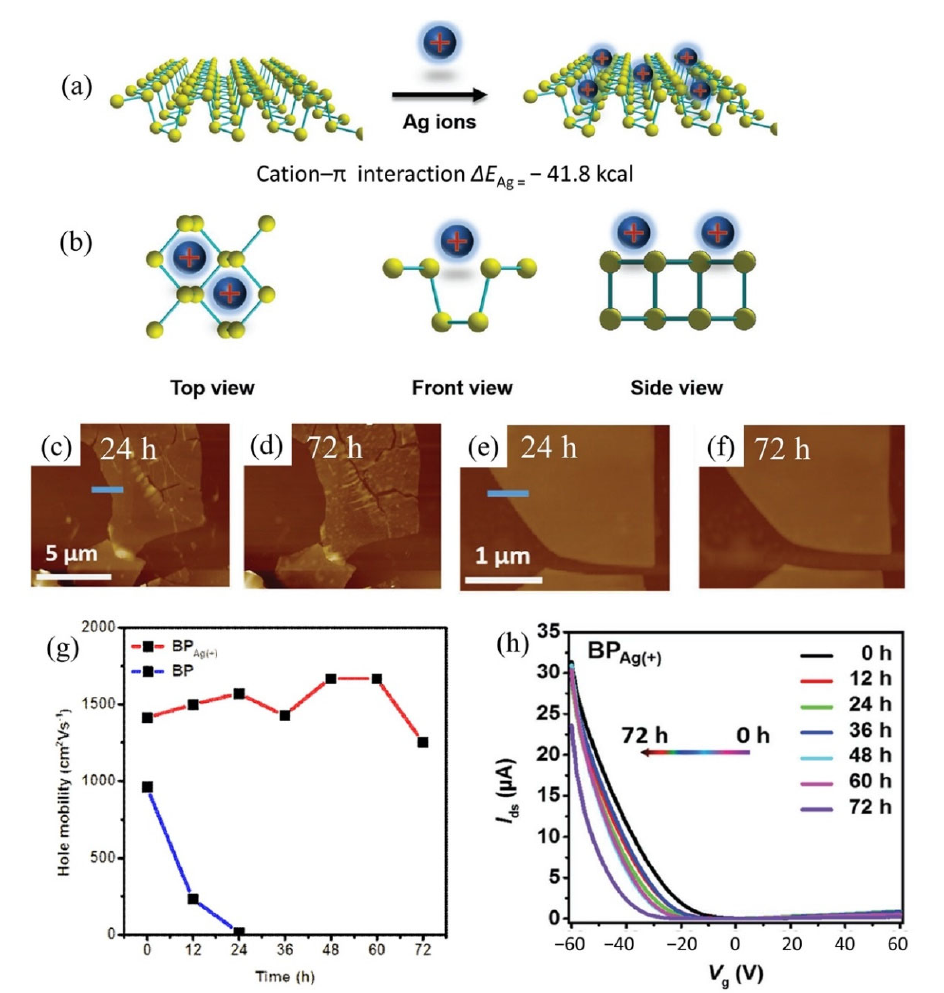
Figure 14. ( a ) Absorption of Ag + on BP layer through conjugated π bond. ( b ) Possible views absorbed Ag + on BP layer. ( c , d ) AFM images of bare BP exposed to air day 1 and day 3, respectively ( e , f ). AFM images of BP Ag+ exposed to air day 1 and day 3, respectively. ( g ) Holes’ mobility of BP and BP Ag+ up to 3 days. ( h ) Drain current performance of BP Ag+ up to 72 h. Reprinted with permission from reference [255]. Copyright 2017 John Wiley and Sons.